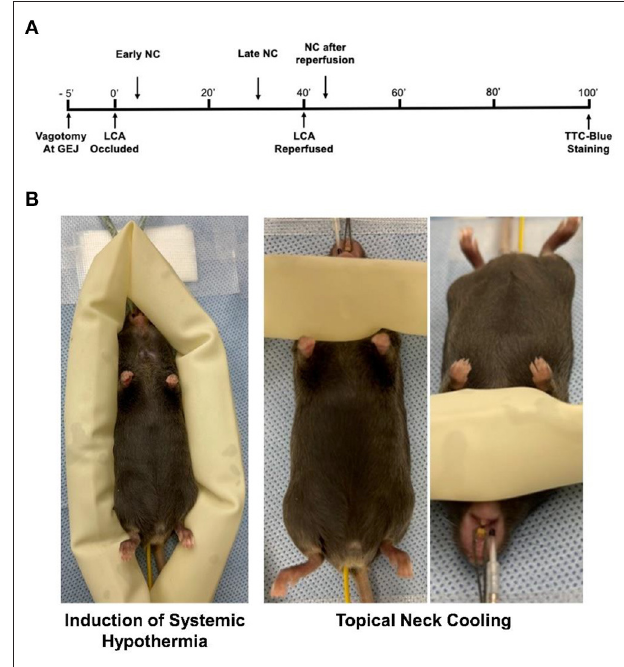
FIGURE 1 | Experimental protocol. (A) C57BL6 mice underwent 40min of LCA occlusion followed by 60min of reperfusion before infarct size was evaluated by TTC-Phthalo blue staining. Topical neck cooling experimental groups underwent early cooling starting 5min after LCA occlusion to 5min after reperfusion, late cooling from 30min after LCA occlusion to 30min after reperfusion, late cooling after vagotomy at gastroesophageal junction